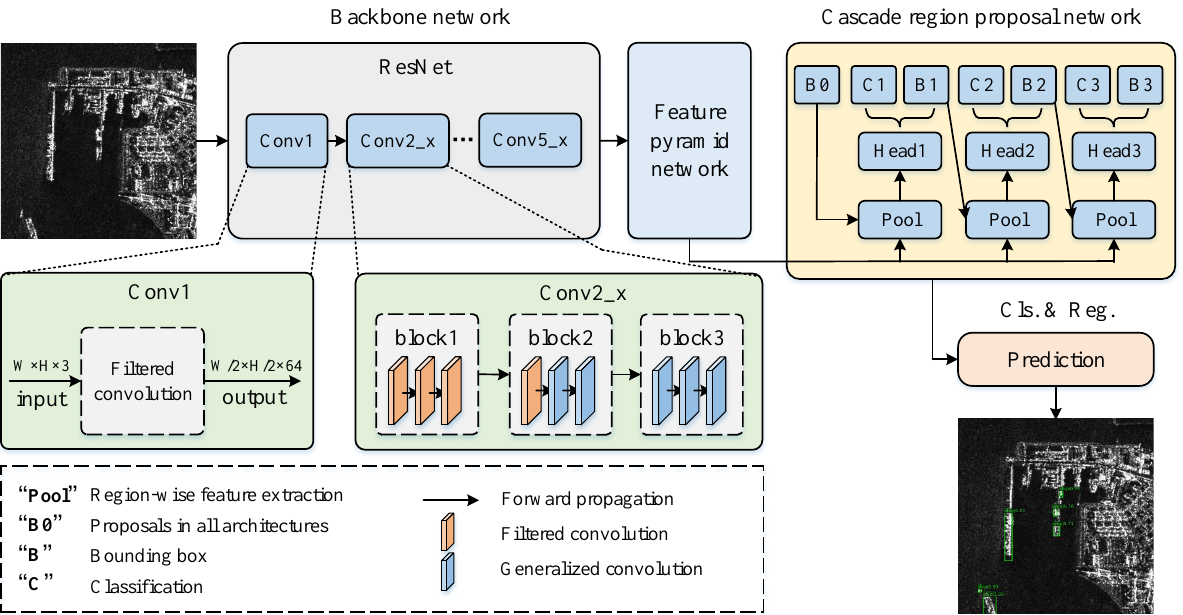
Figure 5. Filtered convolution for ship detection algorithm. Cascade RCNN is used as the baseline method and filtered convolution is applied to the backbone